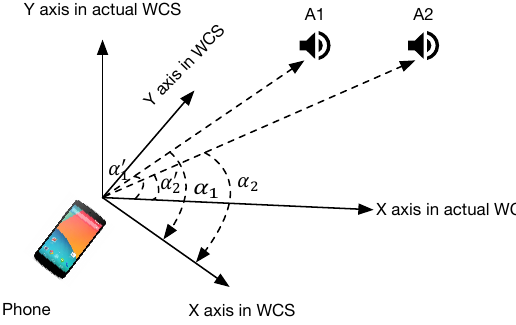
Figure 7. Illustration of the calculated WCS and the actual WCS. The calculated WCS is transformed by the User’s phone Coordinate System using the compass. The α 1 and α 2 represent the calculated relative directions in the WCS, and α (cid:48) and α (cid:48) are their corresponding actual relative directions in the 2 1 actual WCS,